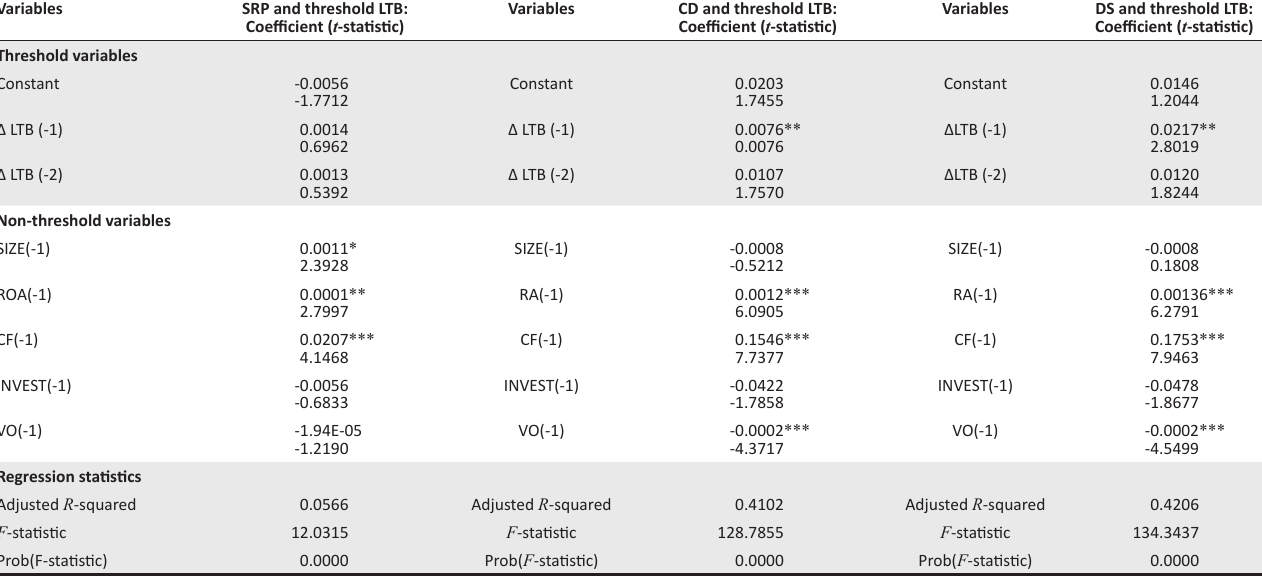
TABLE 4 : Threshold regression approach for distribution strategies and total debt based on the book value (trade-off theory): 1999–2017.